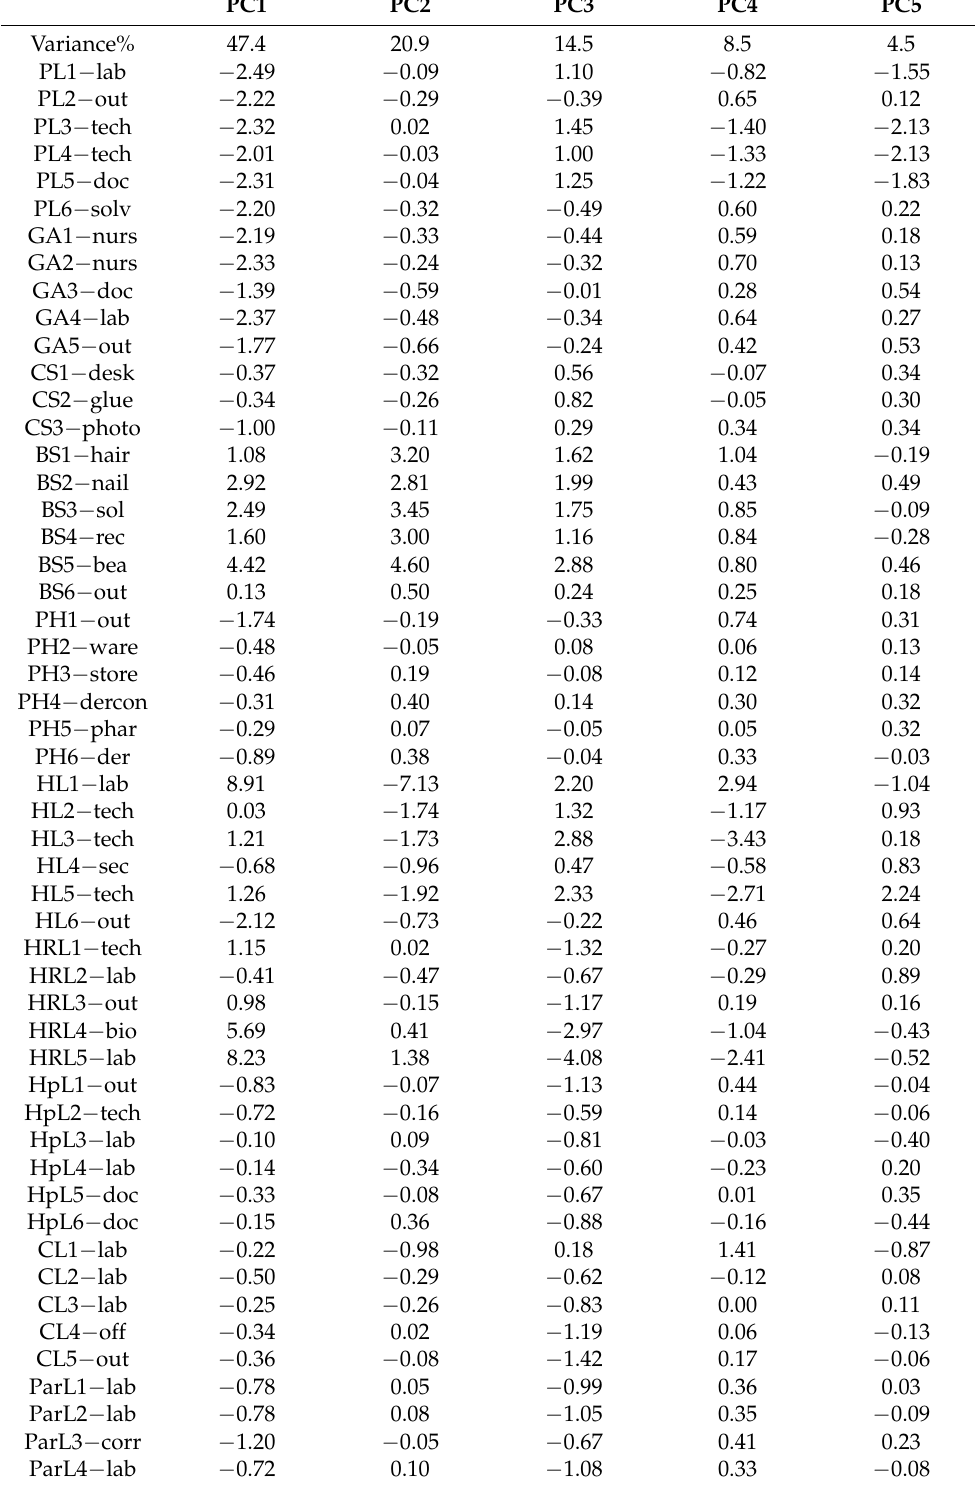
Table 7. Scores and variance % of the five components that were obtained by the PCA that was performed on the concentration data that were yielded at each work